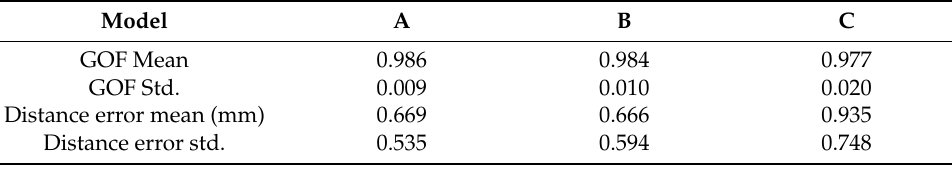
Figure 6. Estimated profile (red) fitted to measured laser data plotted with reference profile (blue) of numerical model for: ( a ) A, ( b ) B, and ( c ) C. Figure 7. Goodness of fit of profile as the azimuth angle varies for models A (blue), B (red), and C (green).